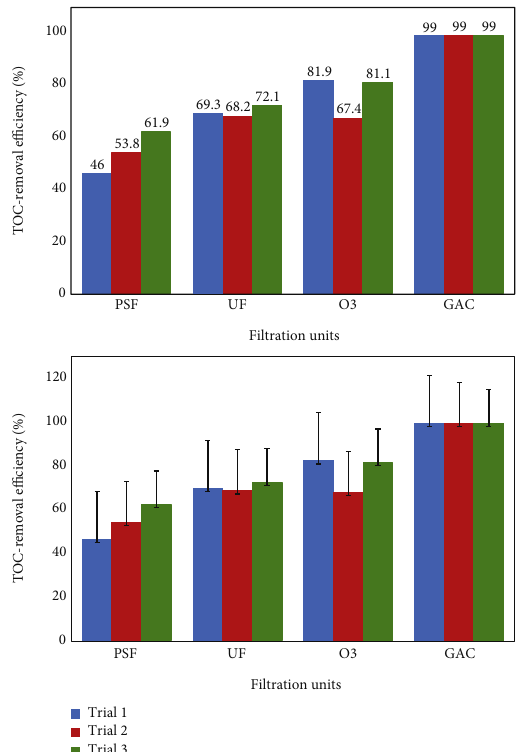
Figure 10: Bar chart representing the removal e ffi ciency of pollutants in PSF, UF, O3, and